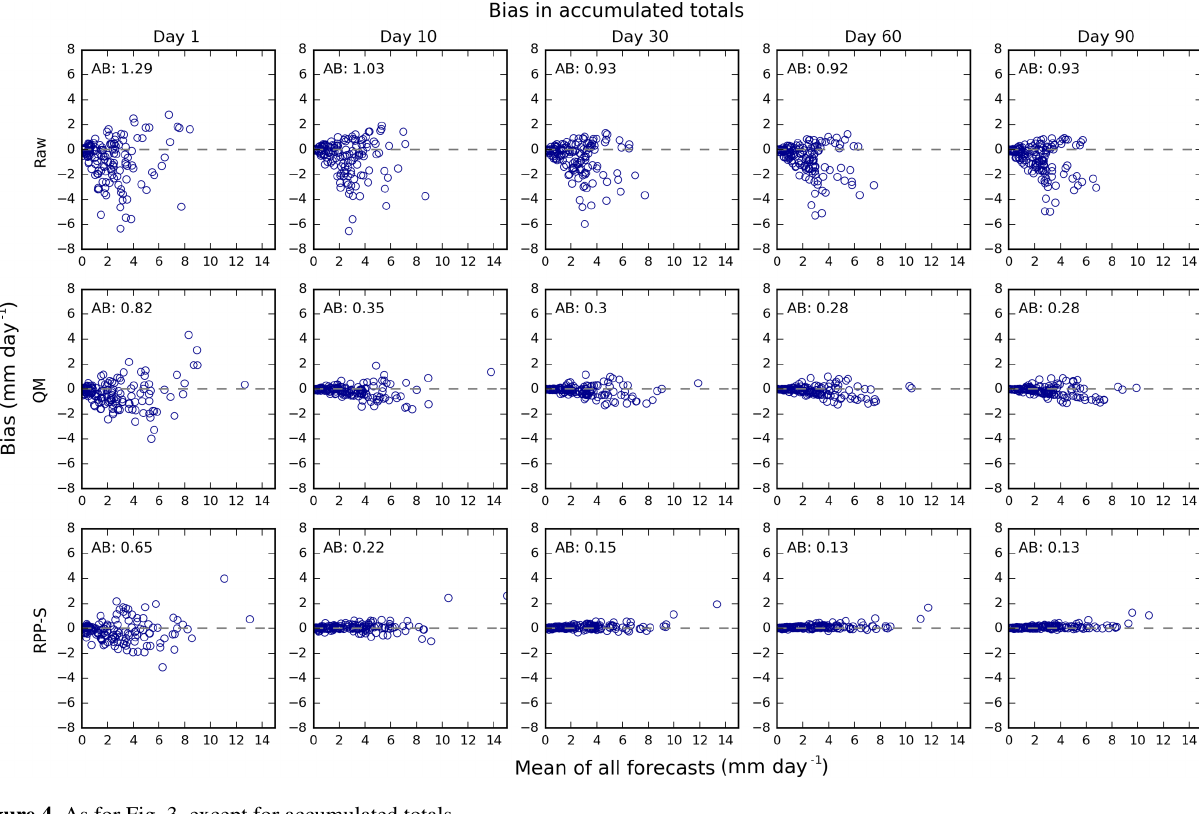
Figure 4. As for Fig. 3, except for accumulated totals.